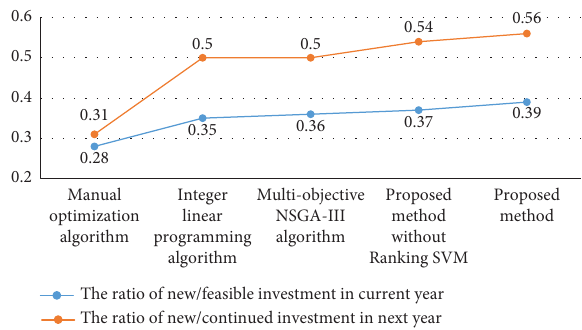
Figure 3: Te satisfaction of fve models about the investment structure constraint. Table 3: Te comparative analysis of fve methods.